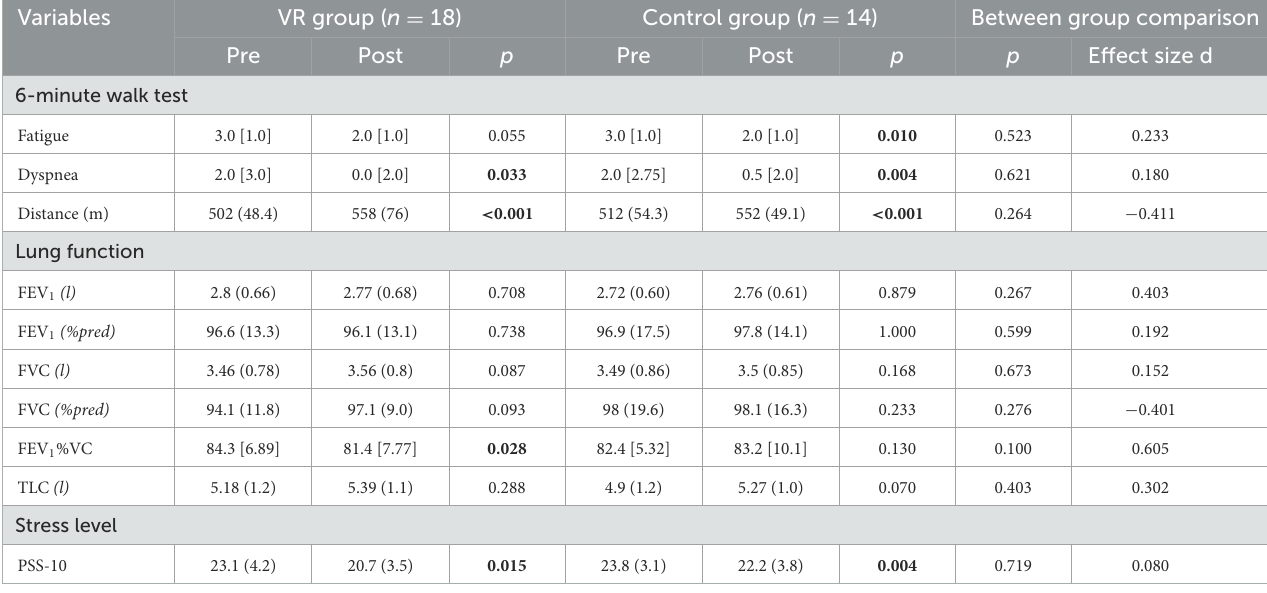
TABLE 3 Results of the analyzed